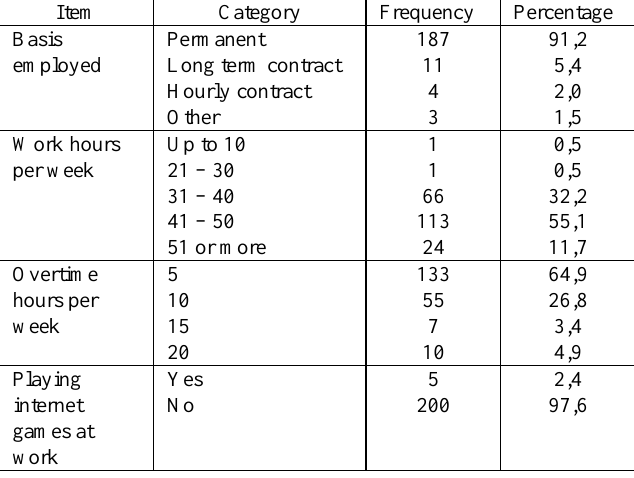
Table 3: Characteristics of the participants ( N=